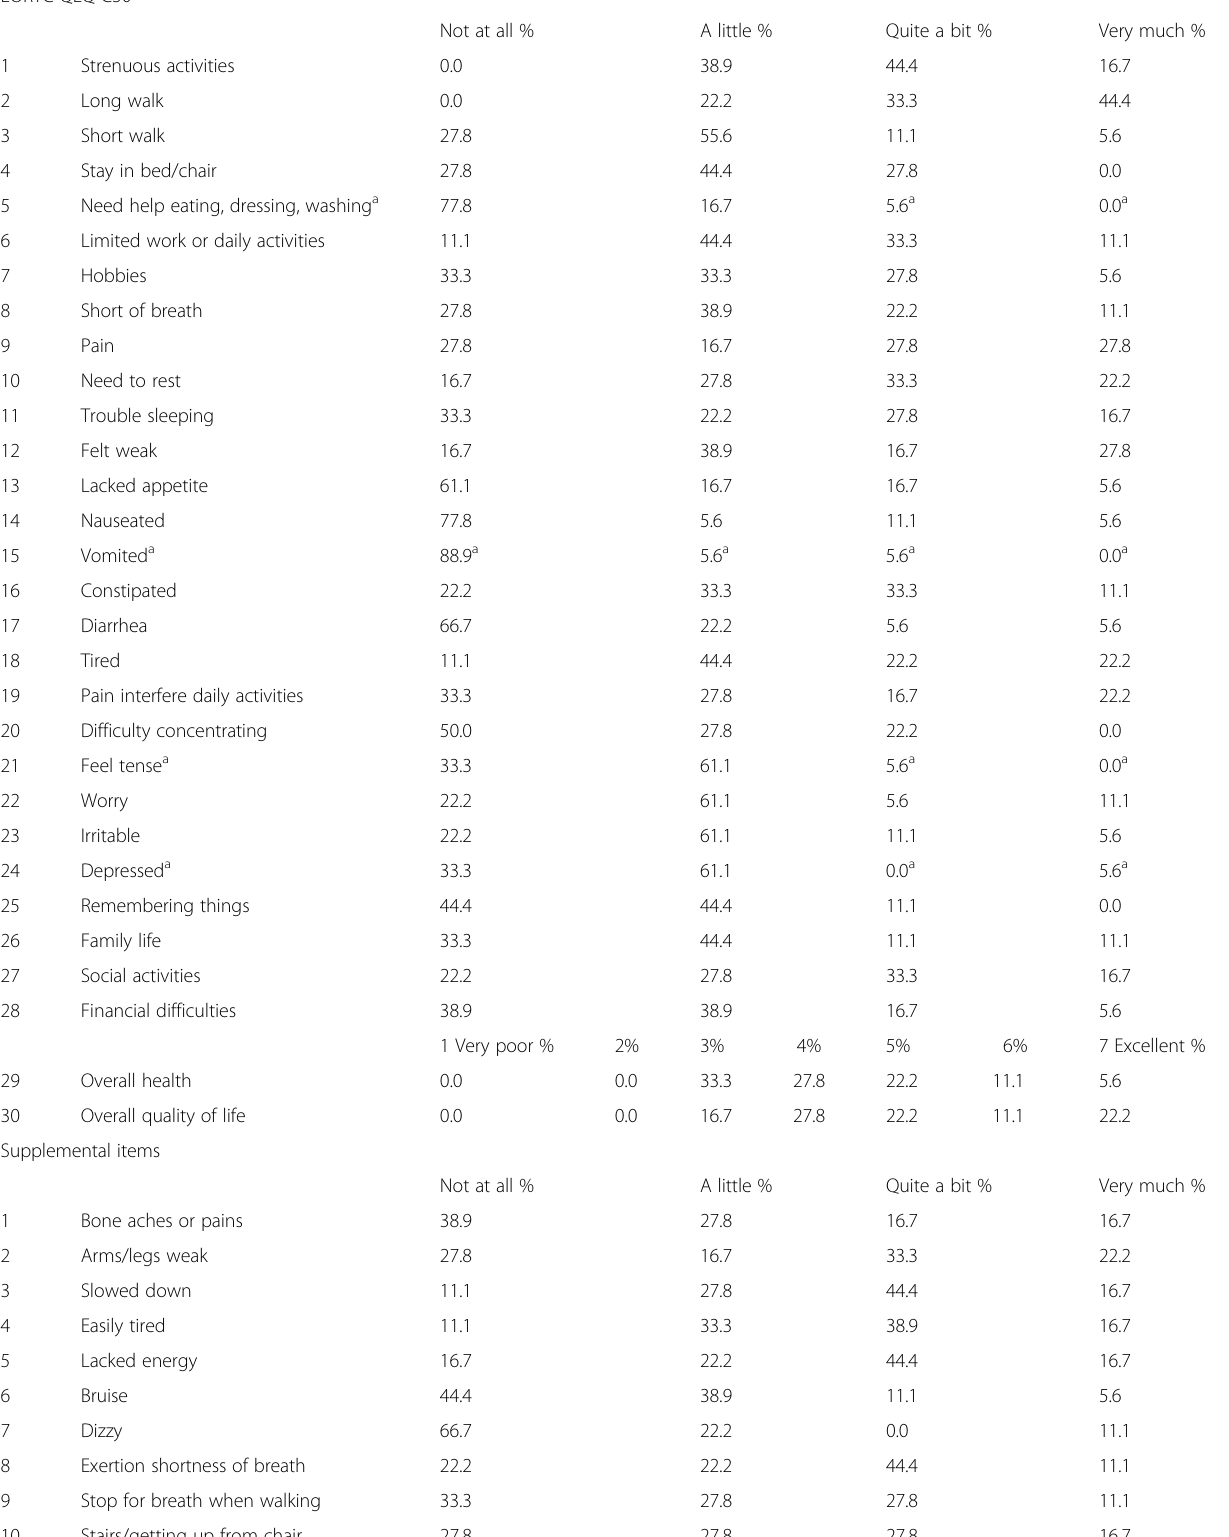
Table 5 EORTC QLQ-C30 and supplemental items: Item-level endorsement frequencies ( n = 18) from Stage